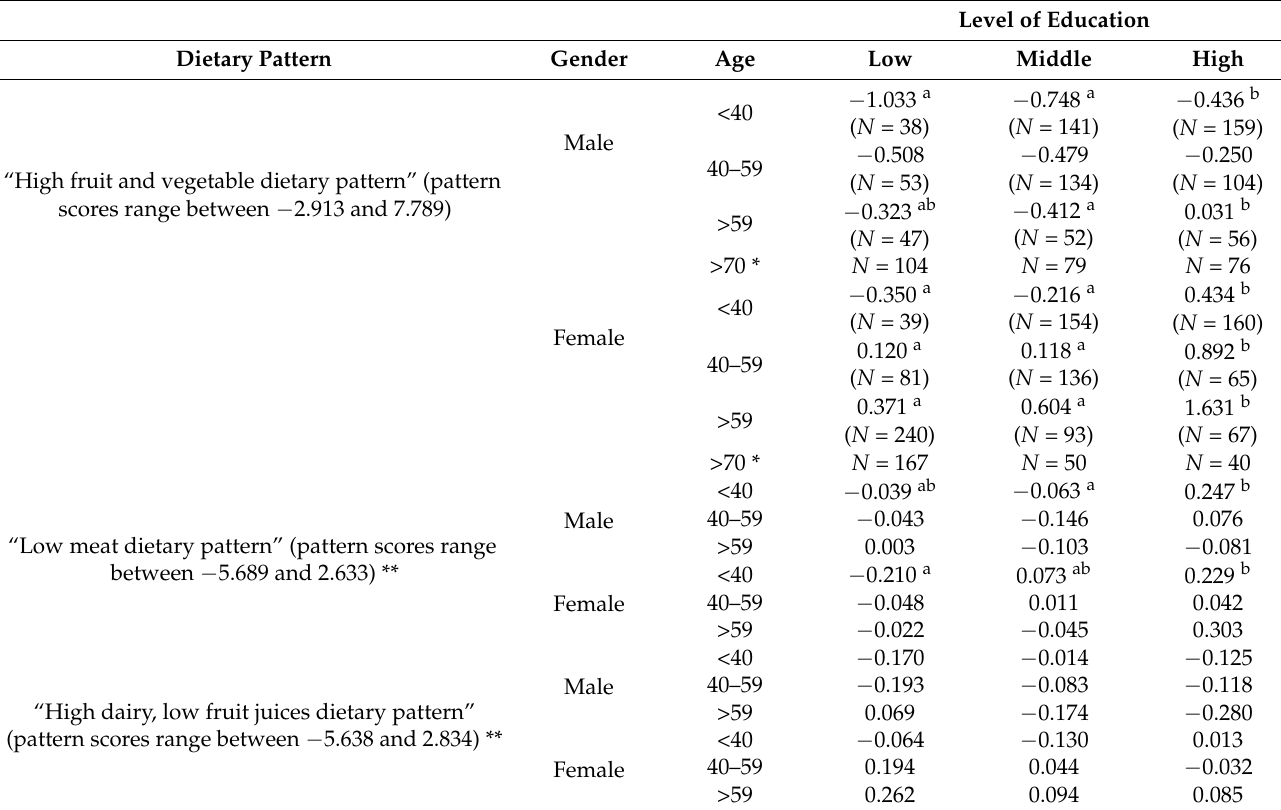
Analysis of covariance: different superscript letters showing significant differences between pattern scores within a row (stratum). Pattern scores are adjusted for body mass index. * From participants aged > 70 years, no information on height was obtained. Therefore, body mass index is missing for these participants, and they are left out of this analysis. ** Number of participants per age, gender, and level of education is similar to the “high fruit and vegetable dietary